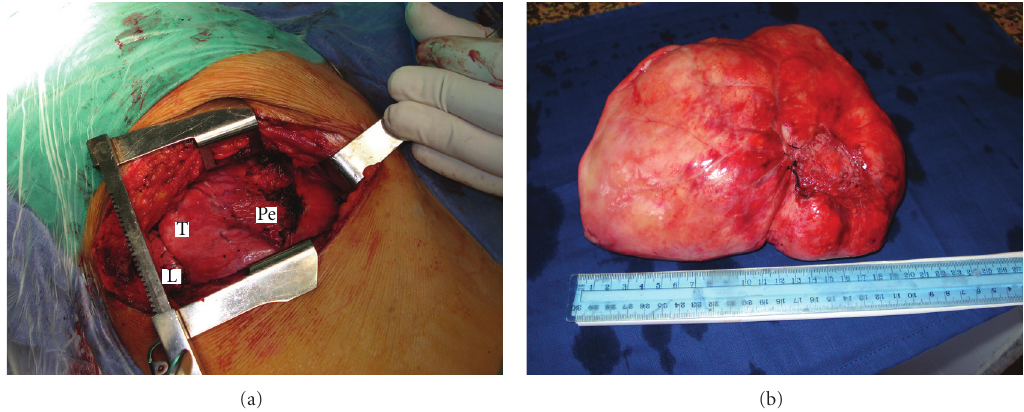
Figure 2: (a) Intraoperative photograph showing the characteristic pedicle (Pe) of a large solitary fibrous tumour of the pleura. L: lung; T: tumour. (b) The giant solitary fibrous tumor was well circumscribed, white, and firm, with a whorled appearance and focal necrosis on cut surface , and was approximately 25 cm in